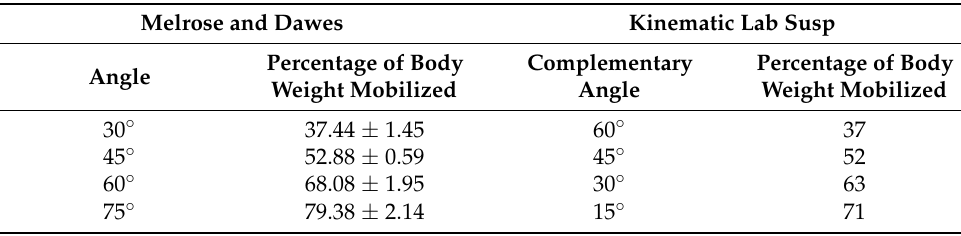
Table 2. Correspondence between the mobilized weight when considering different angles and their complementary ones (based on the equation of Melrose and Dawes [7]).